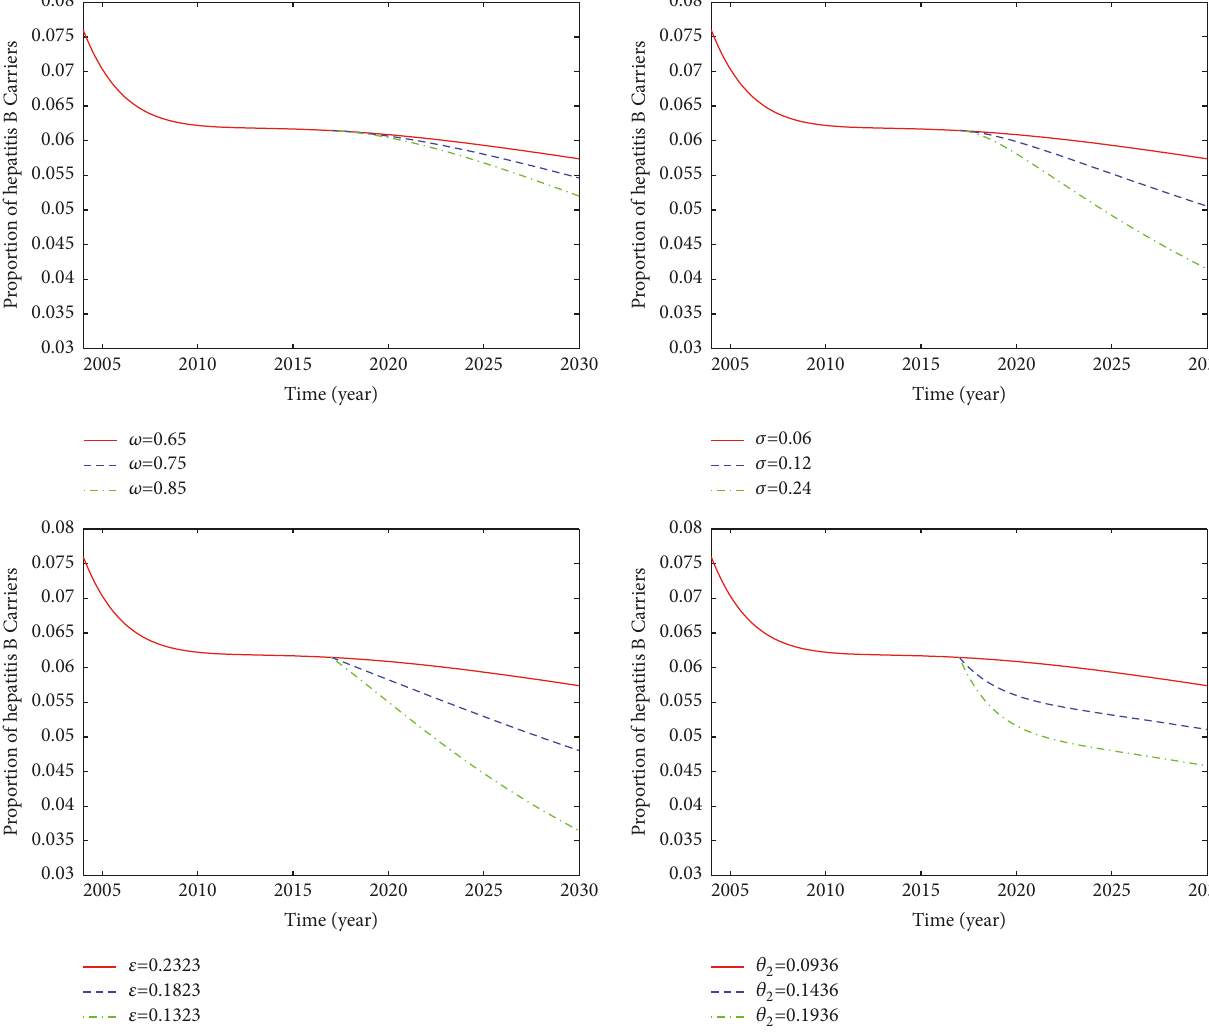
Figure 5: Proportion of chronic carriers against time with the same parameters and initial values as in Figure 4 (solid), compared with the curves of varying 𝜔 , 𝜎 , 𝜀 , and 𝜃 2 in each plot, respectively